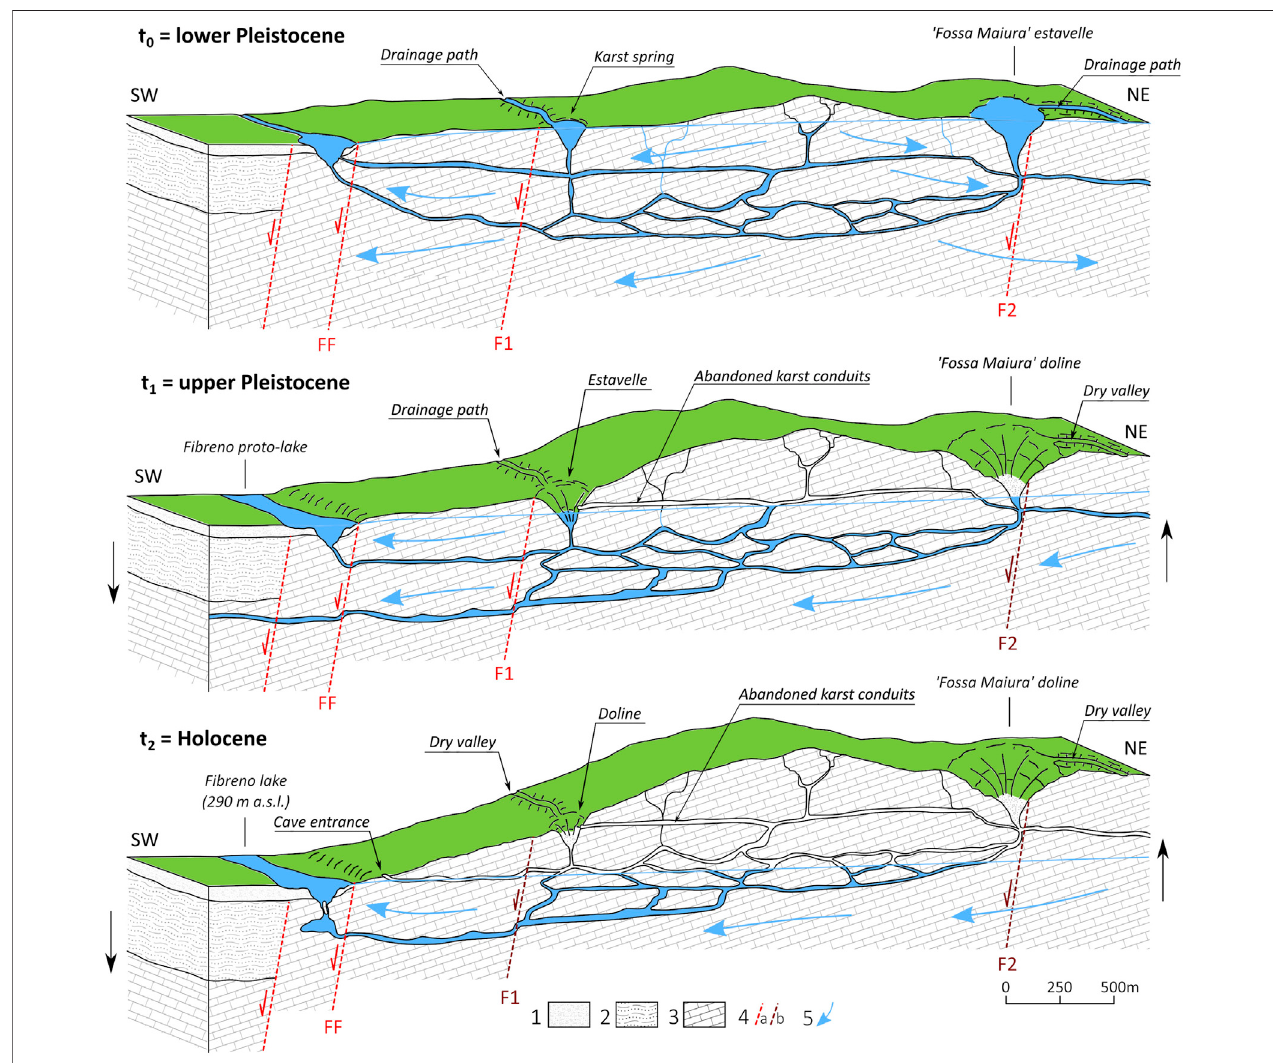
FIGURE 9 | Conceptual sketch of the model and evolution of the Terelle Hill karst system. Key to the legend: 1) Recent and old debris, debris fans, eluvial, colluvial and lacustrine soils (Pleistocene-Holocene). 2) Sandstones and grey clays ( fl ysch) (Tortonian). 3) Limestones and dolostones with hemipelagic marls (Lias - lower Tortonian). 4) Active (a) and inactive (b) faults. 5) Groundwater fl ow. Caves and karst conduits are